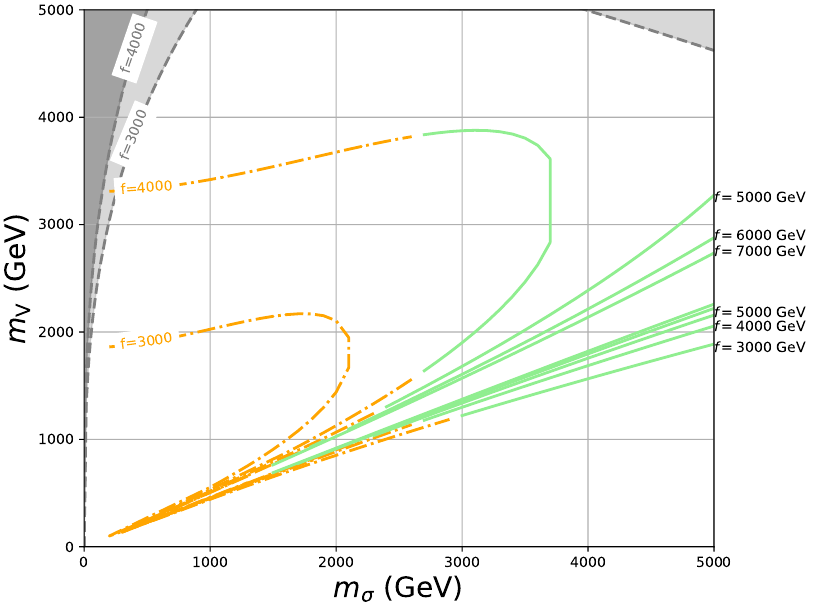
Figure 5 . Dilaton and vector dark matter masses that saturate the observed dark matter relic density (cid:10) h 2 = 0 : 12, for di(cid:11)ering values of f and no mixing between the dilaton and the Higgs boson. The curves are green and solid when the points are not excluded by any observations; they are orange and dot-dashed when excluded by heavy Higgs searches. The dark matter is underdense (and thus allowed if there is another source of dark matter) between the two curves related to a given f value, and overdense (hence excluded unless there is some mechanism to dilute the dark matter density) outside them. For the values f = 3000 ; 4000 GeV the underdense region therefore extends above the curves towards m V ! 1 . Unitarity constraints are shown as the shaded grey